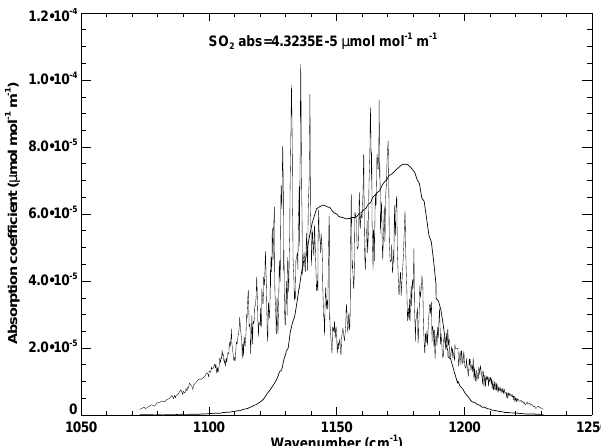
Figure 5. Filter response function (smooth line) for the 8.6µm Cy- FIGURE5. Filterresponsefunction(smoothline)forthe8.6 (cid:22) mCyclopschannelandthevariationofthe SO 2 absorptioncoefficientwithwavenumberasmeasuredbyNIST.Theintegratedabsorptioncoefficient clops channel and the variation of the SO 2 absorption coefficient overthewavebandis4.3235x10 (cid:0) 5 (cid:22) molmol (cid:0) 1 m (cid:0) 1 . with wavenumber as measured by NIST. The integrated absorption coefficient over the waveband is 4.3235 × 10 − 5 µmolmol − 1 m − 1